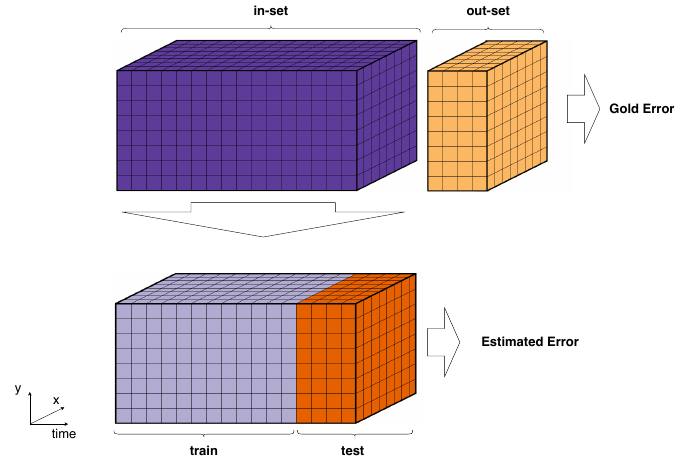
Figure 9. Experimental design for spatiotemporal evaluation procedures assessment. Data are divided into an in-set and out-set, respecting temporal order. The error on the out-set is considered to be the “gold standard”; different estimation methods are used to estimate error on the in-set (in this example, time-wise hold-out). These values are then